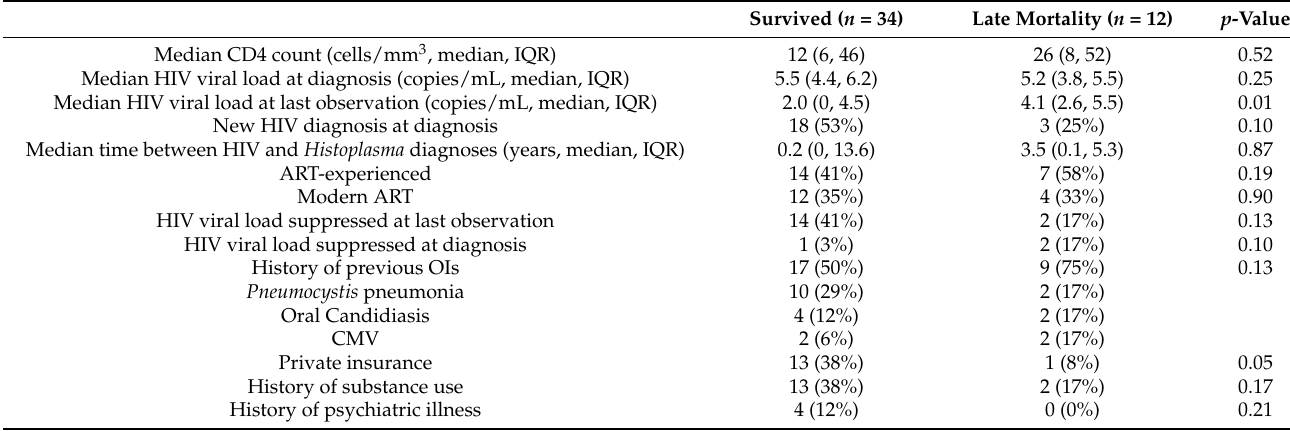
Table 2. Baseline HIV-related characteristics of PWH with histoplasmosis ( n = 46) among two groups (survivors and late mortality)